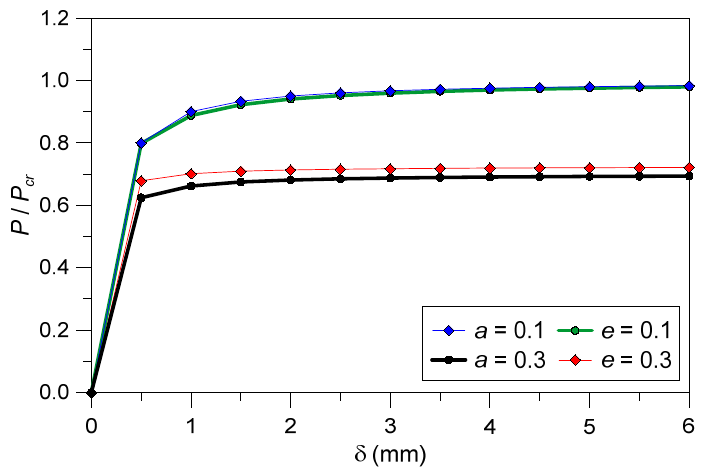
Figure 5. Normalised load versus deflection curves for a compressed member affected by various amplitudes of initial imperfection.